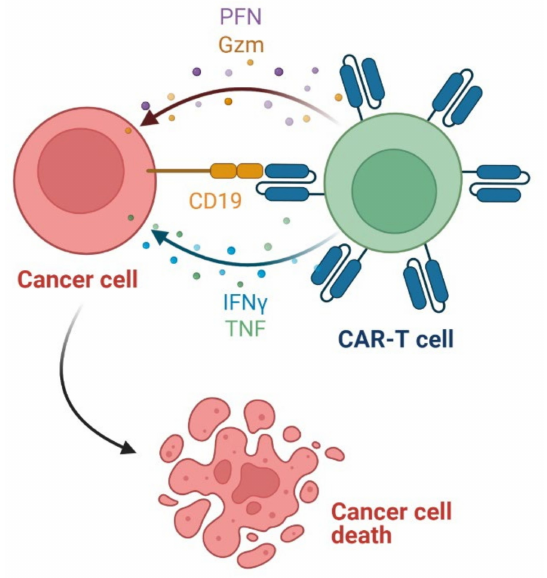
Figure 14. The immune-mediated cytotoxic mechanism of CAR-T cell. PFN : perforin. Gzm : granzymes. CD19 : cluster of differentiation 19. IFN γ : interferon gamma. TNF : tumor necrosis factor. CAR-T : chimeric antigen receptor T. Created with